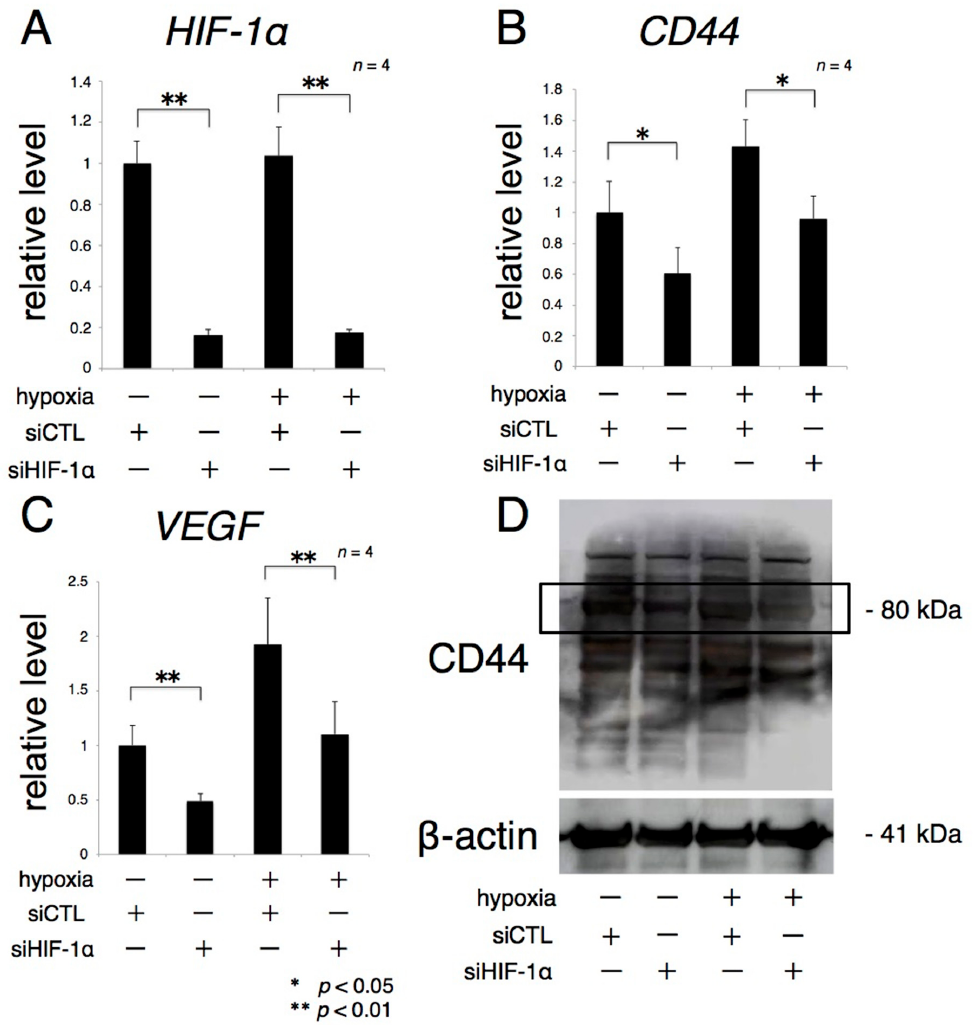
Figure 5. CD44 expression is positively controlled by HIF-1 α . Primary rACs transfected with siHIF-1 α were grown for 72 h in monolayer cultures under normoxic and hypoxic (1% oxygen) conditions. Levels of HIF-1 α , CD44 , and VEGF mRNA were analyzed by real-time RT-PCR ( A – C ); CD44 protein expression was analyzed by Western blotting ( D ); β -actin was used as the loading control. * p < 0.05, ** p <